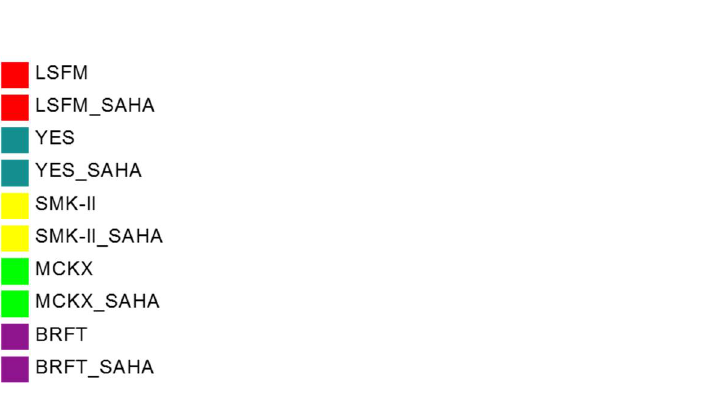
Figure 9. Dice-UPGMA dendrogram of similarity relationship between the metabolomic profiles of the fungal population ( n = 232) cultured in five fermentation media with and without SAHA.